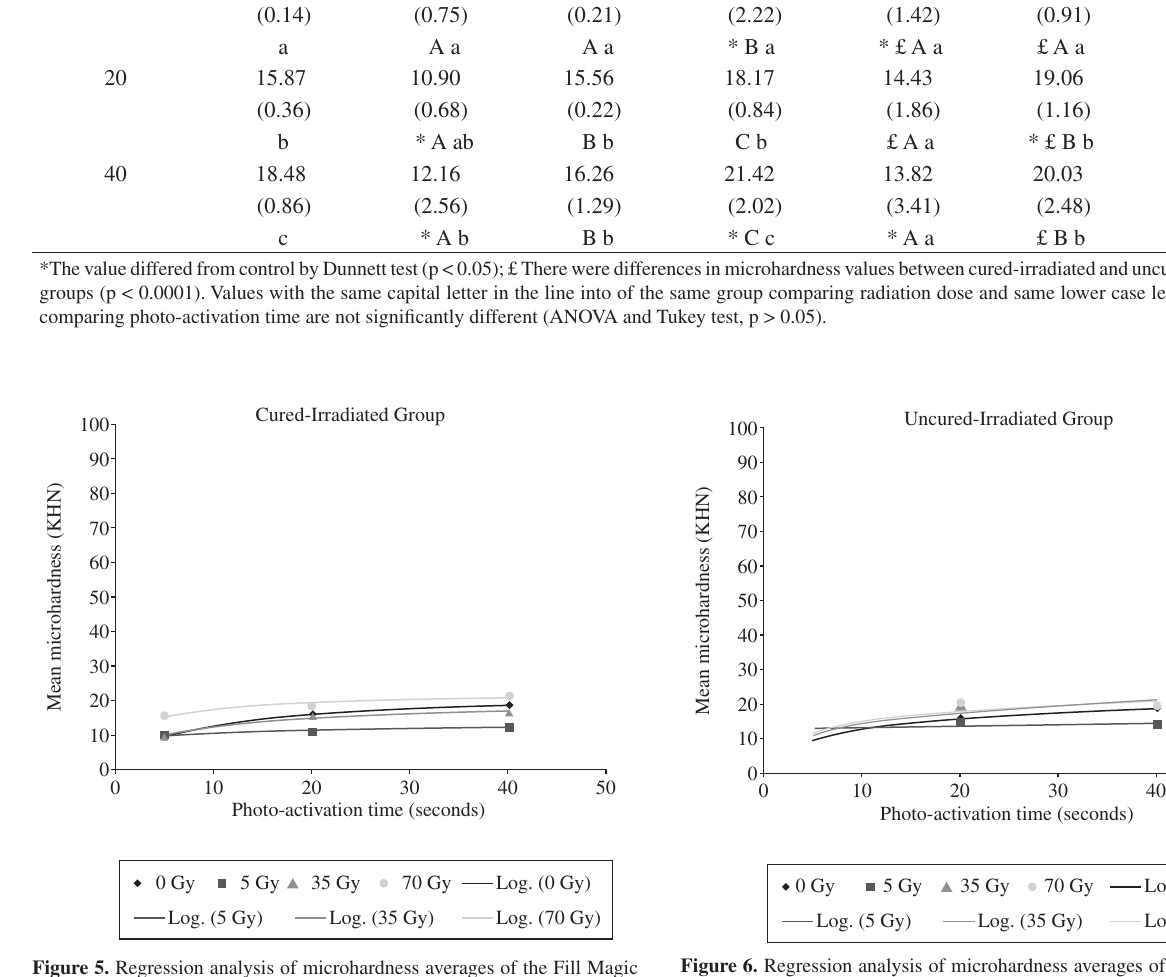
Figure 5. Regression analysis of microhardness averages of the Fill Magic Flow ® material to cured-irradiated groups in accordance with radiation dose as a function of the photo-activation time.